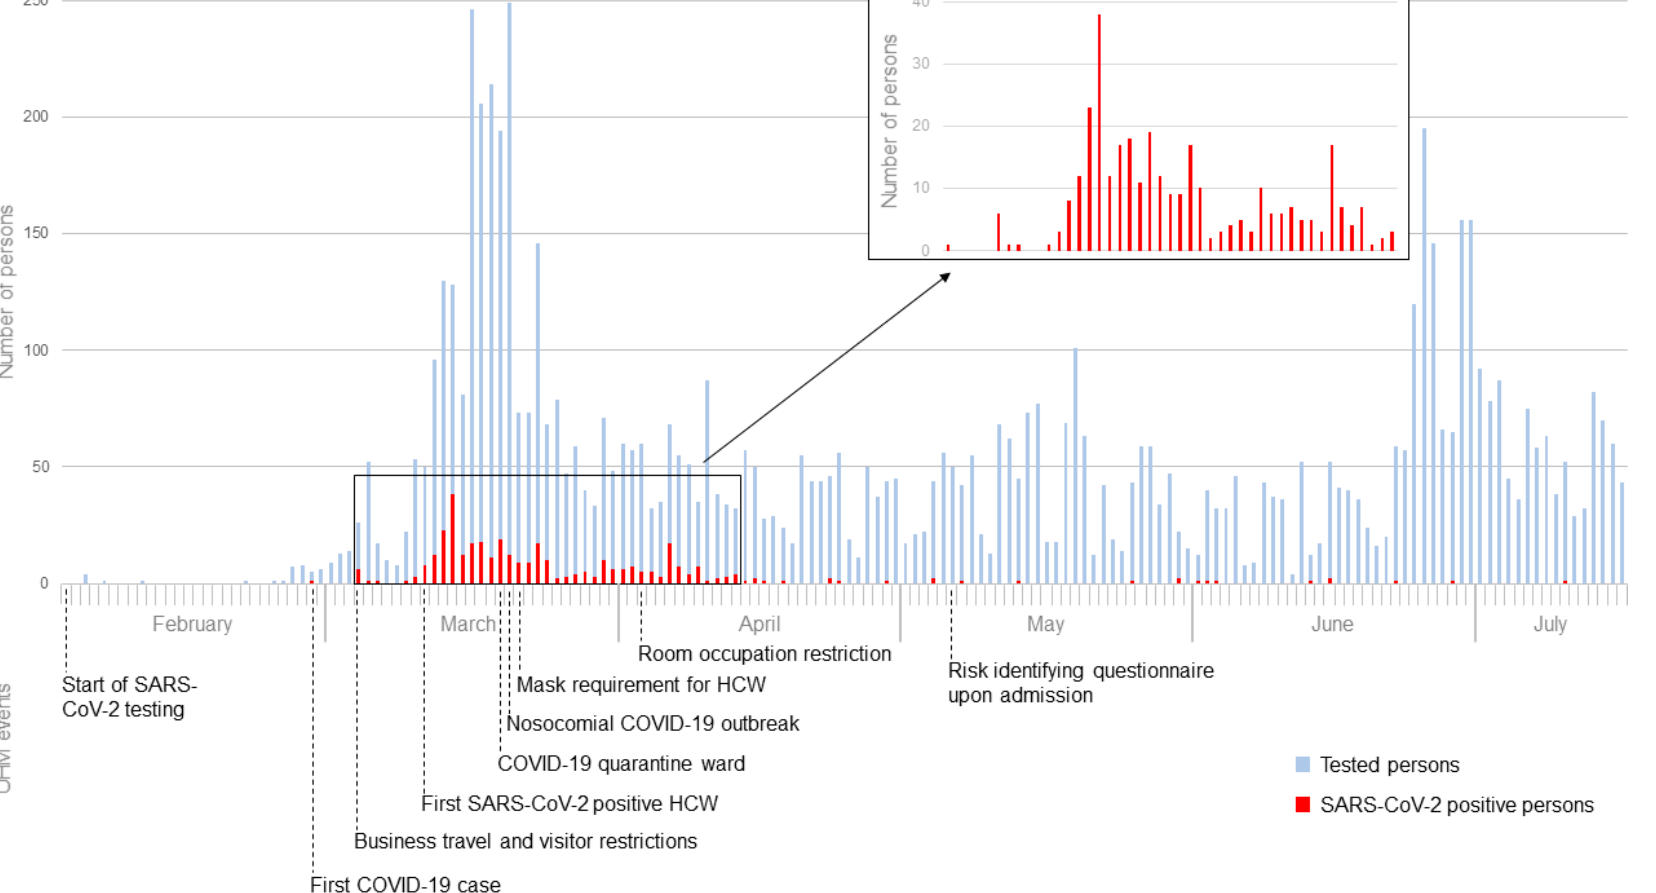
Figure 1. Management of the COVID-19 pandemic in the University Hospital Münster (UHM). Numbers of persons tested and with SARS-CoV-2 positive test results are listed in an epidemiologic curve. Events and prevention strategies in the UHM are mentioned in the lower part.